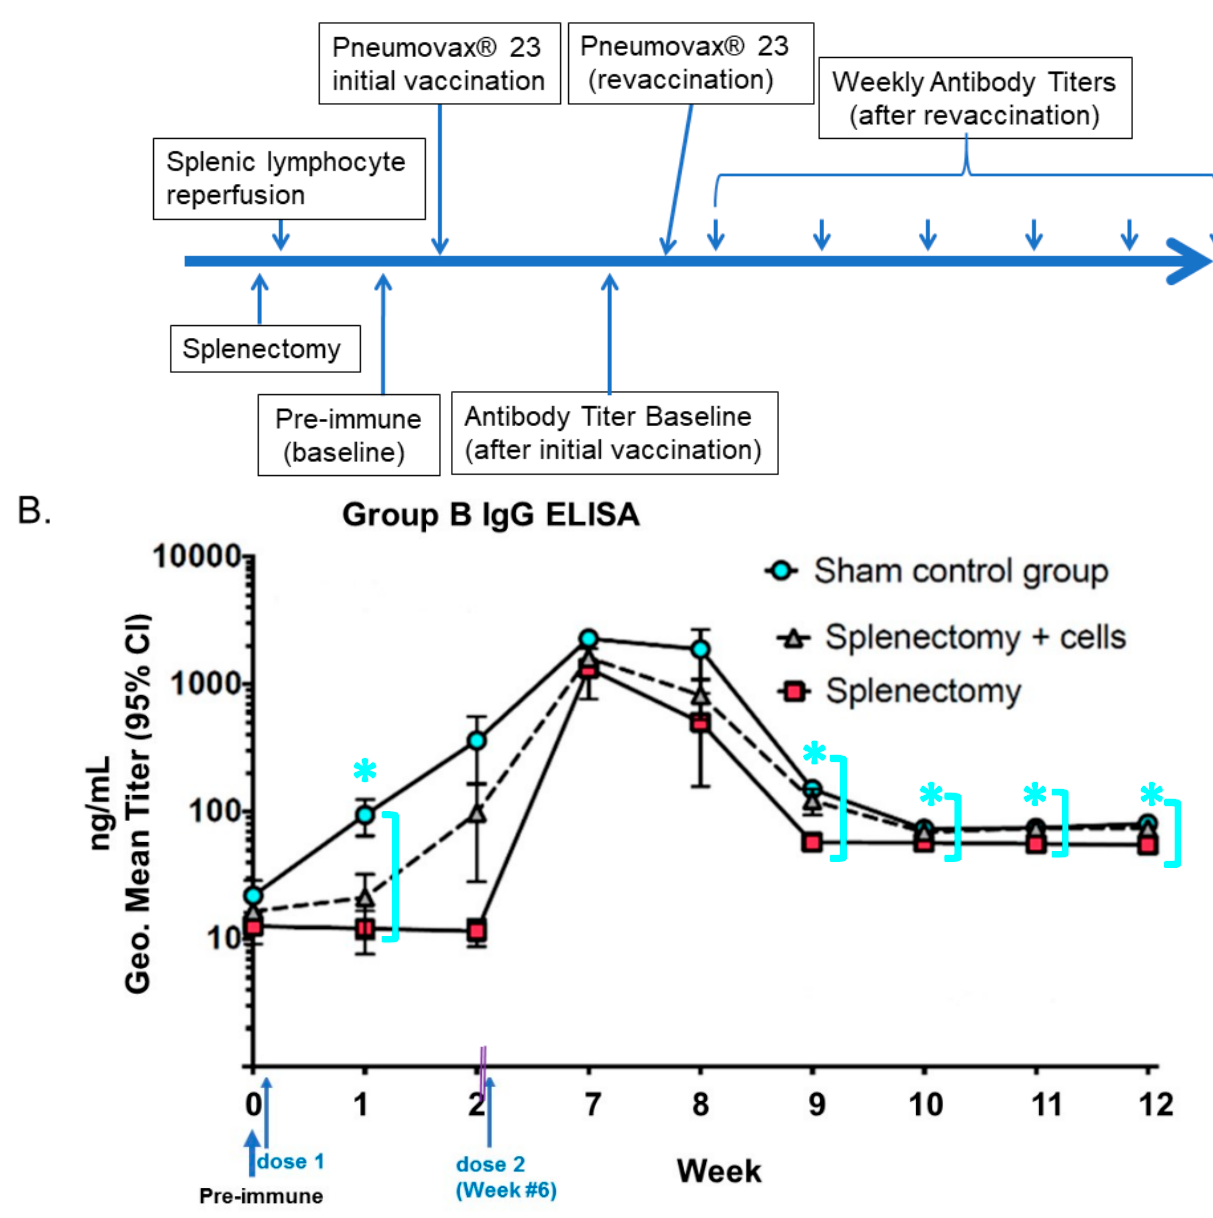
Figure 1. Humoral antibody-mediated immune response to PPSV23 vaccination in a mouse model following splenectomy. ( A ) Timelines of PPSV23 vaccination. ( B ) Antibody IgG titers of Balb/C mice with the repeat vaccination (6 weeks) and tested against polysaccharides conjugated to ELISA plates. (* signals the statistically significant, p < 0.001, sham control subgroup being compared with − SL subgroup for weeks 10, 11, 12), as sky-blue circles compared with red squares (splenectomy), as shown with mean ± S.D. concentrations (ng/mL titers) and 95% confidence intervals as measured by ELISA with Log10 scale). Doubled-purple-lines defined a time gap from 2 weeks to the repeat vaccination at 6 weeks. (“Geo.”: it stands for geometric mean.). (Refer to [14] for details). [Figure reproduced License 4.0 (CC BY-912)].